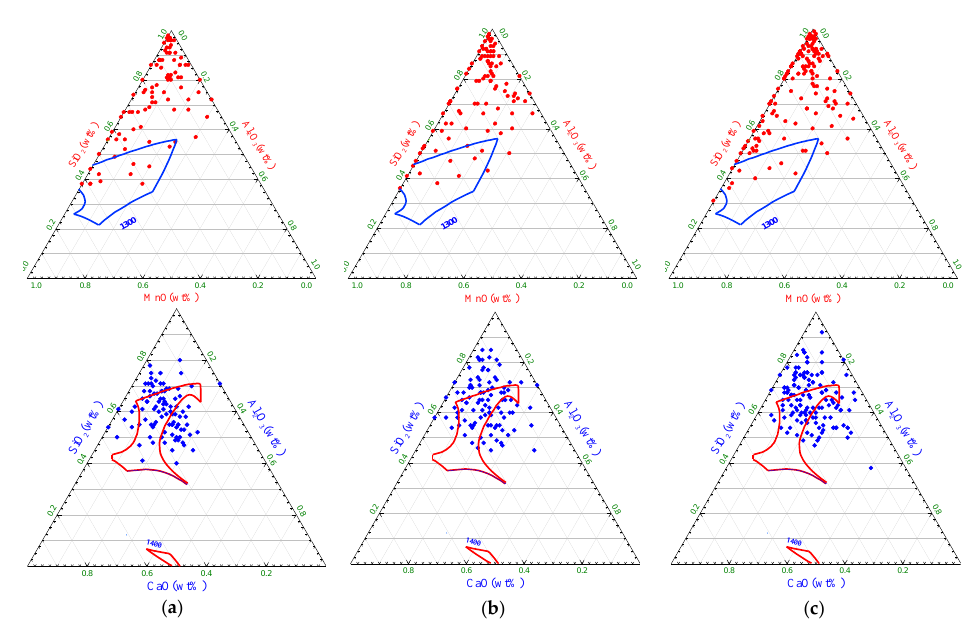
Figure 4. Inclusion distribution overlayed on phase diagram with refining time in 2 # steel sample: ( a ) 900 s (15 min); ( b ) 1800 s (30 min); ( c ) 2700 s (45 min).